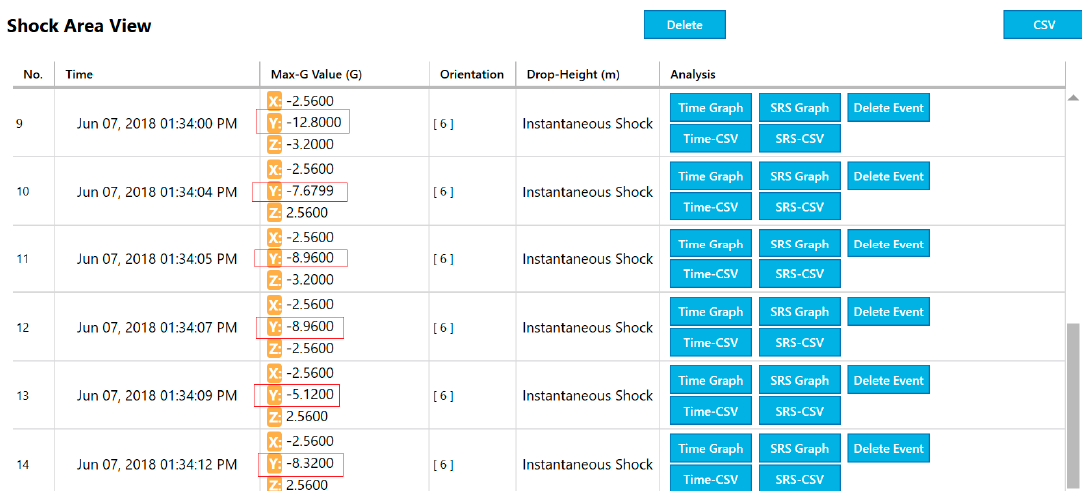
Figure 10. Exemplary shock data collected by the bottom data logger on the DJI Matrice 100.